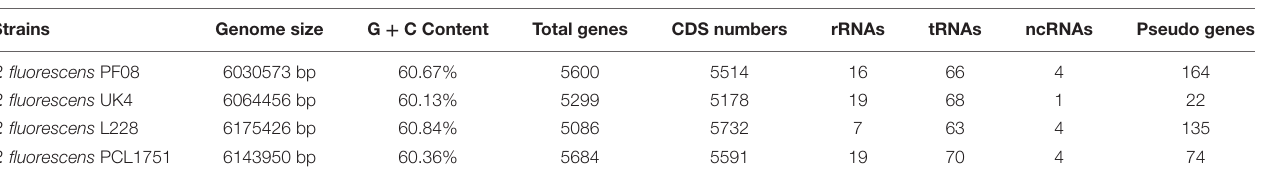
TABLE 1 | General features of PF08 and other Pseudomonas fluorescens